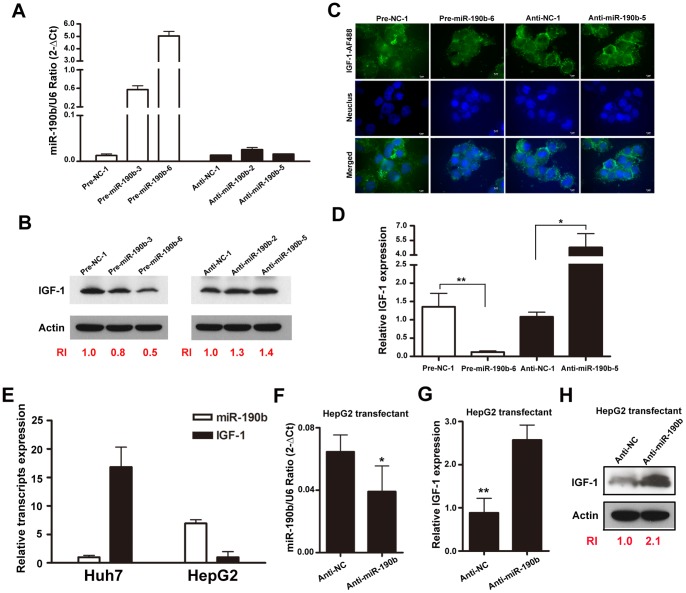
The regulatory effects of miR-190b on IGF-1 expression.(A) qRT-PCR assay verified the relative miR-190b expression in Huh7 stable cells clones. (B&C) Overexpression of miR-190b attenuated IGF-1 protein expression, and blocking miR-190b moderately increased IGF-1 protein expression. These results were assayed by western blotting (B) and immunofluorescence staining (C), respectively. (D) IGF-1 mRNA was detected by qRT-PCR in stable cells expressing precursor miR-190b or inhibitor miR-190b. Relative expression of IGF-1 compared to negative control (NC) was calculated using the 2−ΔΔCT methods. (E) The endogenous transcript levels of miR-190b and IGF-1 were dertermined by qRT-PCR in Huh7 and HepG2 cells. (F&G) qRT-PCR analysis of miR-190b (F) and IGF-1 (G) in HepG2 cells transfected with anti-NC or anti-miR-190b vectors. (H) Western blotting of IGF-1 in HepG2 cells transfected with anti-NC or anti-miR-190b vectors. Relative intensity (RI) shown was calculated by normalization of the intensities of IGF-1 from the internal controls. **, P<0.01 and *, P<0.05 as compared to each of the negative control cells.